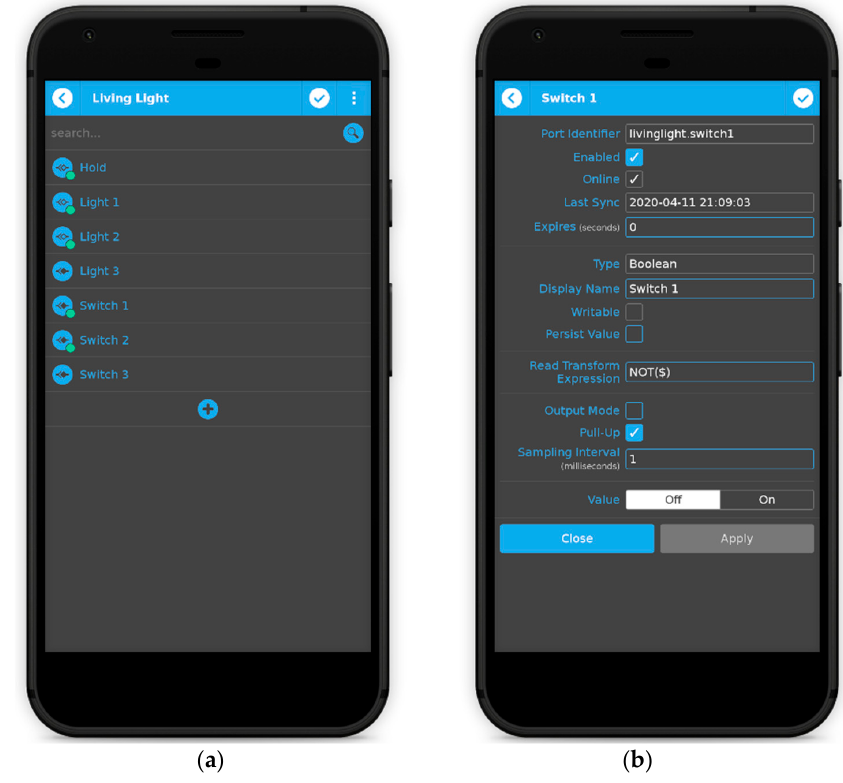
Figure 6. Adding, removing ( a ) and configuring ports ( b ).